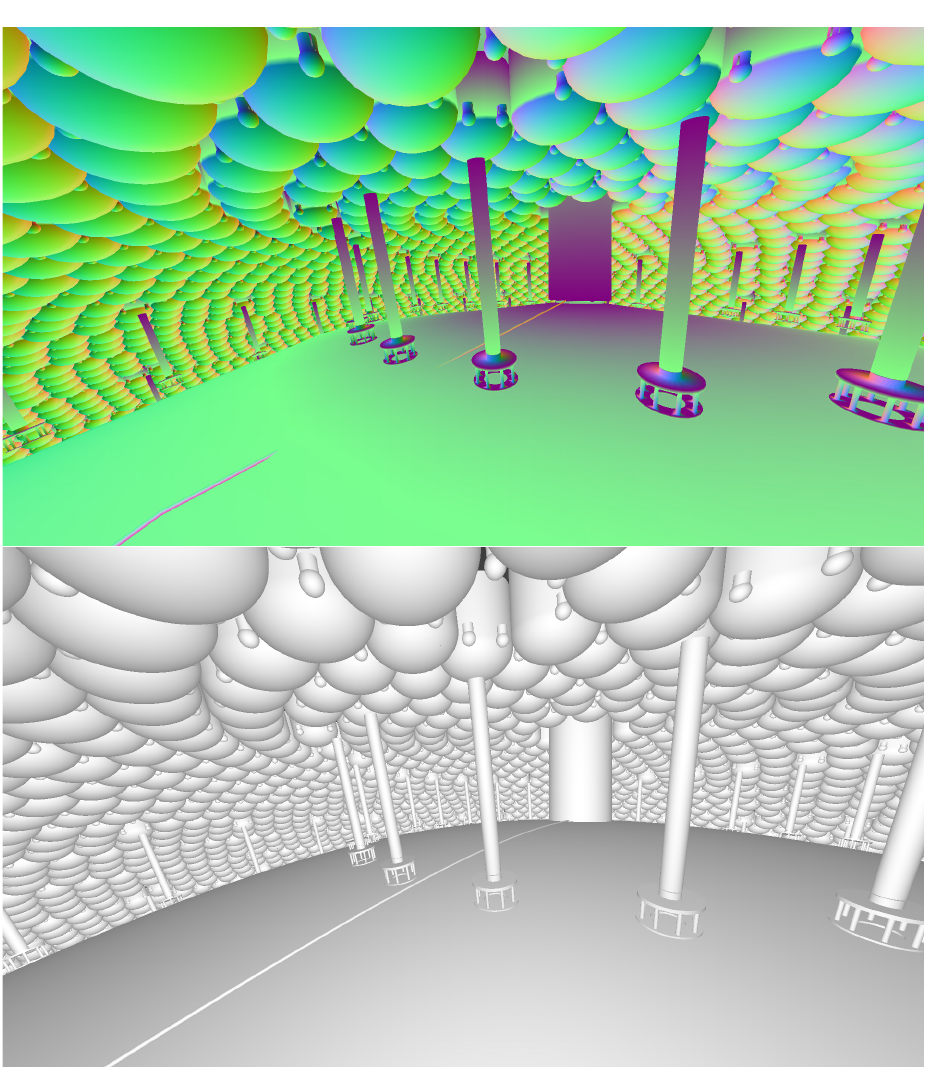
Figure 2. Renders of the chimney region of JUNO detector showing photomultiplier tubes, acrylic sphere, supports and calibration guide tube torus. The geometry was directly converted from Geant4 into an Opticks geometry including analytic CSG as well as approximate mesh representations of all solids, and persisted into a geometry cache of NumPy[17] binary files. The upper render is an OpenGL rasterization of the mesh geometry. E ff ects of the approximation are visible with the guide tube torus appearing to impinge into the acrylic sphere. The lower render is a ray-traced image of the analytic CSG geometry which is the same geometry used in the